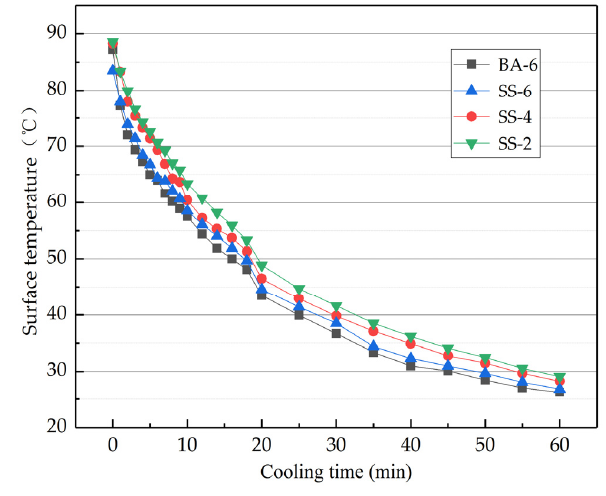
ff erent asphalt Figure 14 Cooling time of different asphalt concrete. Figure 14. Cooling time of di Figure 14 Cooling time of different asphalt concrete. Figure 14 Cooling time of different asphalt concrete.